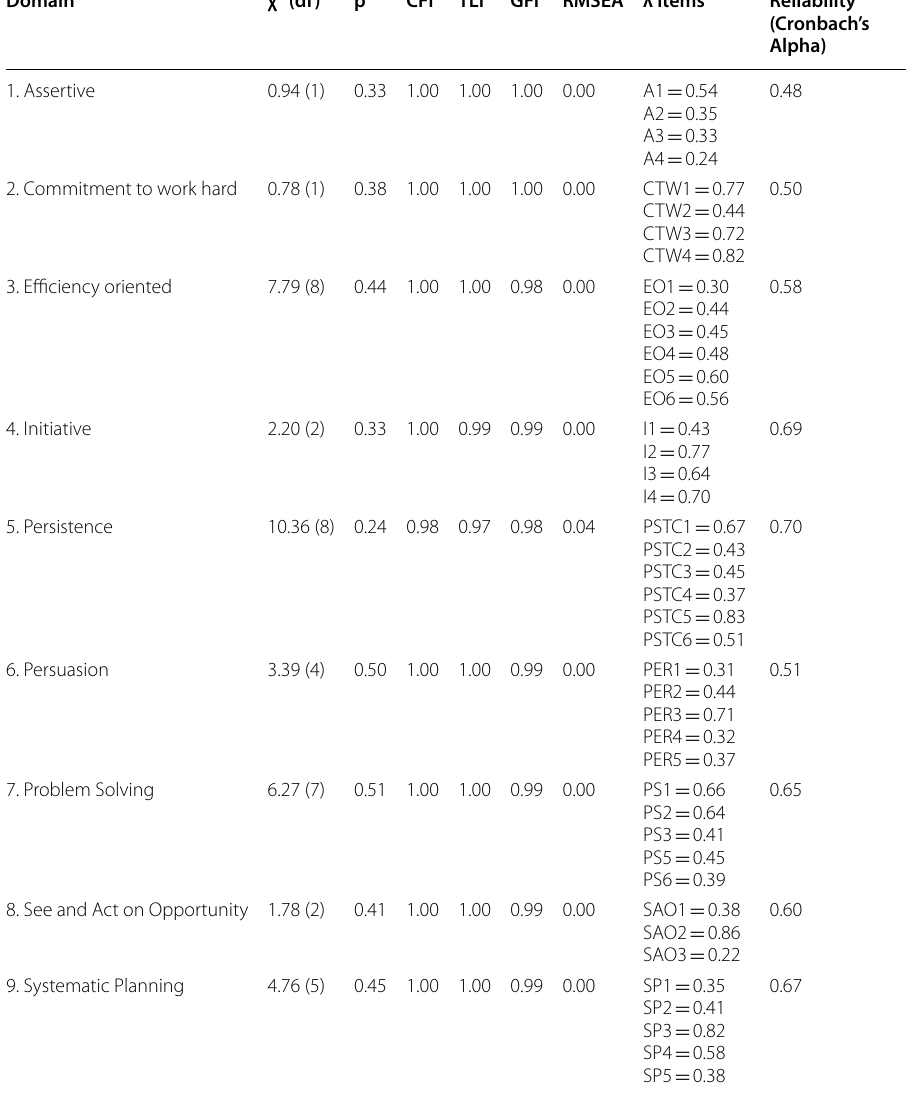
Table 3 Confirmatory factor analysis of the Indonesian entrepreneurial competence